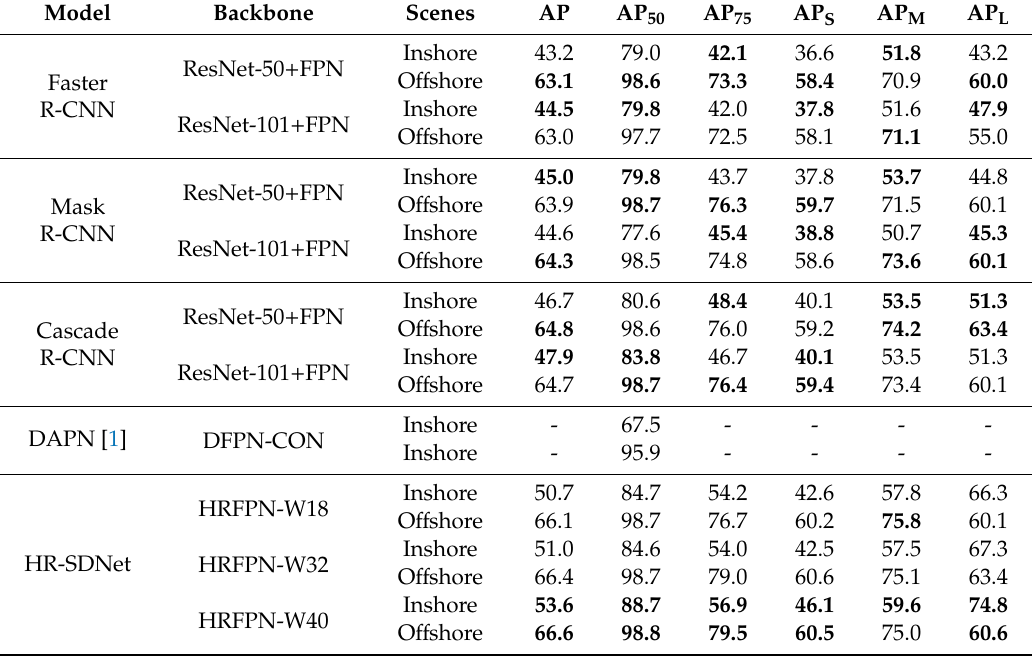
Table 6. Comparison with the state-of-the-art Single-Model Detectors in the Inshore and O ff shore Scenes on the SSDD Data